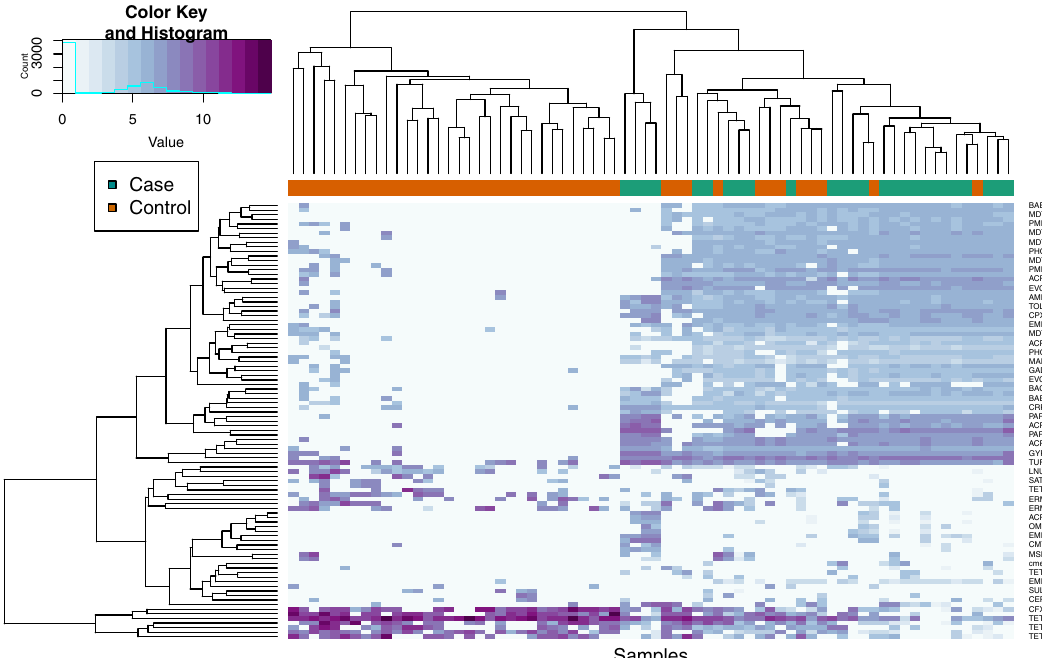
Figure 4. Hierarchical clustering illustrates group level ARG abundance differences between cases and controls. The columns represent the resistome communities per sample, which are ordered based on similarity in the top X-axis dendrogram that displays two resistome clusters. Case and control samples are indicated by the color bar below the dendrogram (cases = cyan; controls = orange). The Y-axis shows the hierarchical clustering of ARG groups as they appear in sample resistomes; ARG group names are indicated in small print on the right. Those ARG groups with a cumulative normalized abundance value < 5 across all samples were excluded from the analysis. Relative abundance is indicated by the color key; a value of 15 (deep purple) indicates that there are approximately 15 normalized copies of that ARG in a sample, while a value of 0 (light blue/white) indicates a very low or negligible